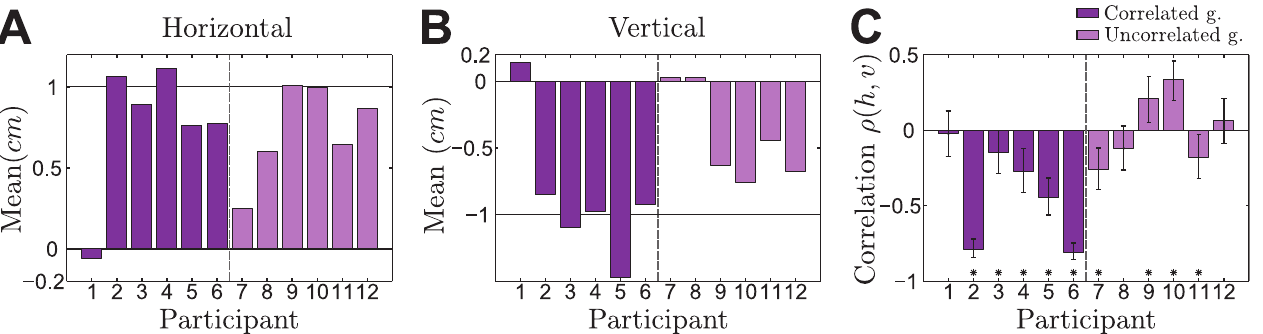
Fig 5. Means and correlation of the final hand position in no-feedback trials of the last session. A The mean of the final horizontal hand position for an ideal actor should be +1 cm to fully compensate the mean shift. B The mean of the final vertical hand position for an ideal actor should be − 1 cm to fully compensate the mean shift. C Correlation coefficient between the vertical and horizontal components of the final hand position. Error bars indicate 95% confidence intervals — bars marked with a star show significant correlations (at a 5% level).